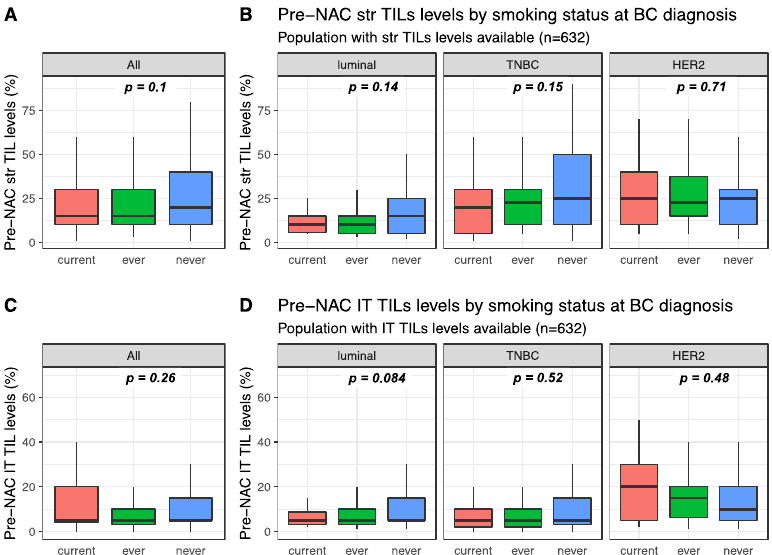
Figure 1. Pre-NAC TIL levels at breast cancer (BC) diagnosis according to smoking status: ( A ) Pre-NAC str TIL levels in the whole population, ( B ) Pre-NAC str TIL levels by BC subtype, ( C ) Pre-NAC IT TIL levels in the whole population, ( D ) Pre-NAC IT TIL levels by BC subtype.